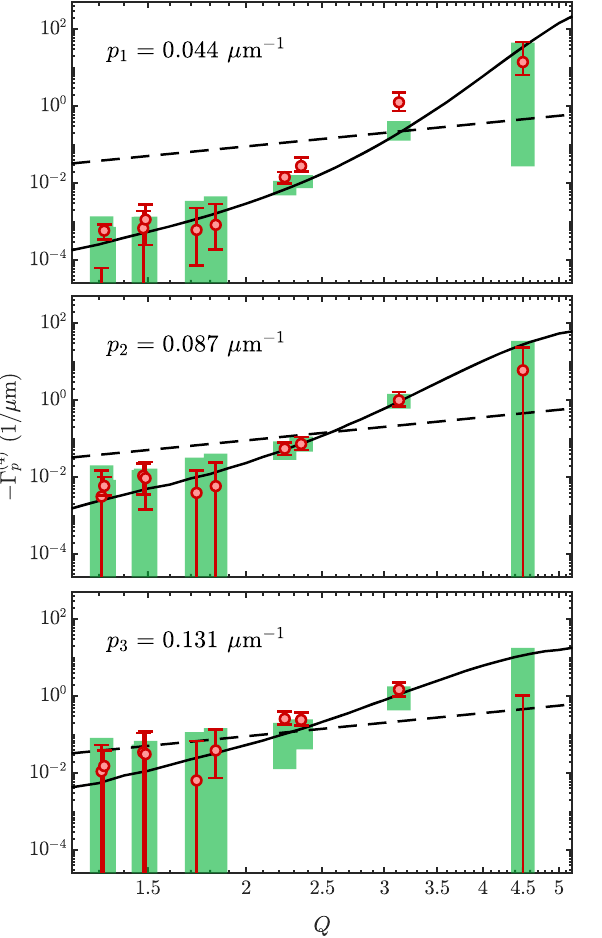
subplots.FIG. 10. Experimental four-vertex. The red bullets represent the experimental results for the four-vertex as a function of Q ¼ λ = l . The points in one particular subplot correspond to T J separate measurements with different tunneling strengths. The different subplots show the results for the lowest three values of p indicated in the upper left corner of the subplots. The error bars represent 80% confidence intervals obtained using bootstrapping. The numerical prediction from the sine-Gordon model in thermal equilibrium is given by the green bars. The height of the bars indicates the 80% confidence interval for the theory predictions considering the finite experimental sample size. Note that all uncertainty comes from the finite sample size; no uncertainty in the parameters λ and Q is assumed. The width of the bars is T chosen arbitrarily. The solid black line represents the theory prediction from 10 6 numerical realisations and the dashed black line the tree-level prediction